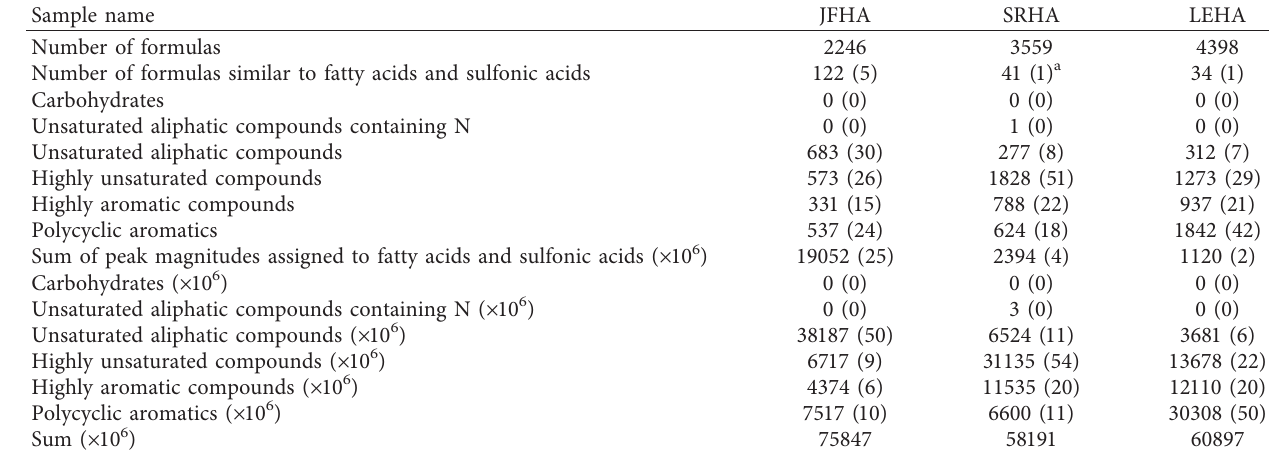
Table 2: Number of peaks assigned to molecular formulas having similar elemental composition to each compound group and the sum of their peak